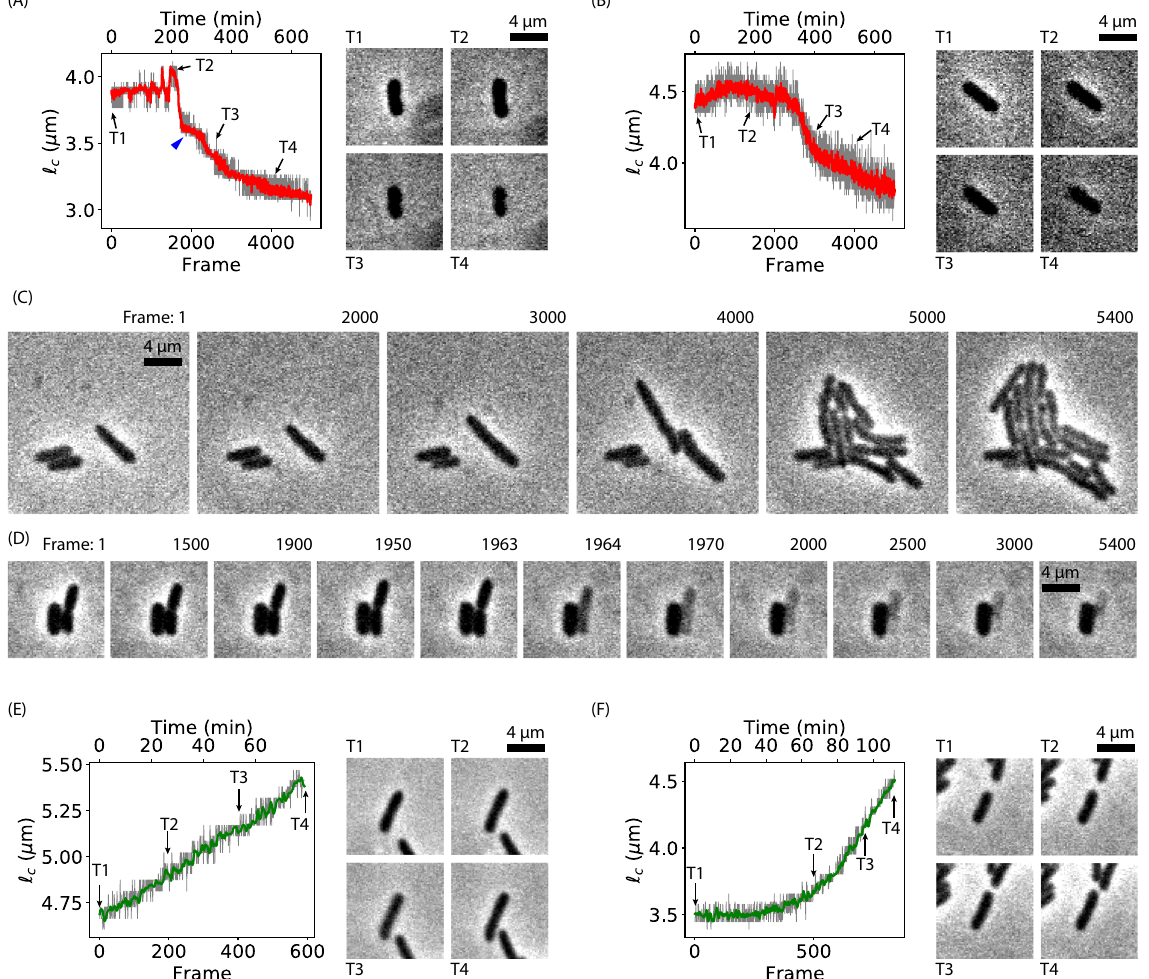
Figure 2. Heterogeneity of bacterial responses to Ag + treatment. ( A,B ) Cell-length as a function of frame number (time) for two examples of shrinking bacteria in the presence of Ag + ions. Representative frames were labeled by arrows and numbered as T1, T2, T3, and T4. Images of the bacteria in the frames { T i } are shown in the right panels, extracted from ( A ) SI Movie M8 and ( B ) SI Movie M9. ( C ) Frames of SI Movie M10 showing the growth of bacteria starting between Frame 2000 and 3000. ( D ) Frames of SI Movie M11 showing the burst of two cells happening between Frame 1950 and 2000. ( E,F ) Cell-length as a function of frame number (time) for two examples of growing bacteria in the absence of Ag + ions (i.e., negative control). Representative frames were labeled by arrows and numbered as T1, T2, T3, and T4. Images of the bacteria in the frames { T i } are shown in the right panels, extracted from ( A ) SI Movie M13 and ( B ) SI Movie